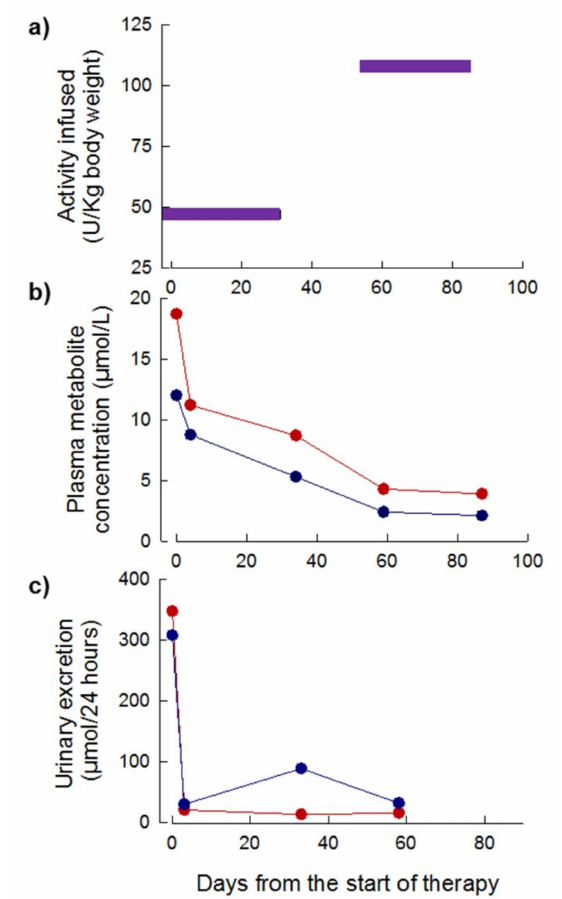
Figure 8. Dose of EE-TP administered, plasma concentrations of deoxyribonucleosides and urinary excretion of deoxyribonucleosides in Patient 3 during six months of therapy with EE-TP. ( a ) The dose of encapsulated thymidine phosphorylase infused was determined using HPLC. ( b ) Intra-cycle plasma thymidine (blue data points) and deoxyuridine (red data points) concentrations were measured by UPLC. ( c ) Intra-cycle urinary excretions of thymidine (blue data points) and deoxyuridine (red data points) were determined by measuring the concentration of metabolites in 24 h urine